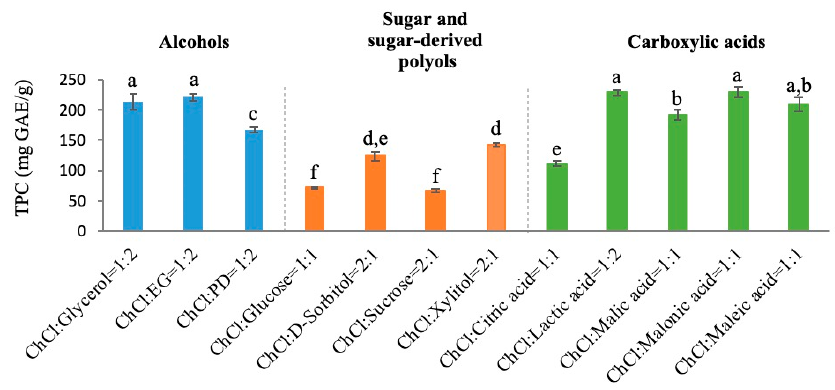
Figure 1. Total phenolic content (TPC) values of the green tea extracts based on 12 selected DESs. Data (a–f) are expressed as means ± SD of n = 3 samples.